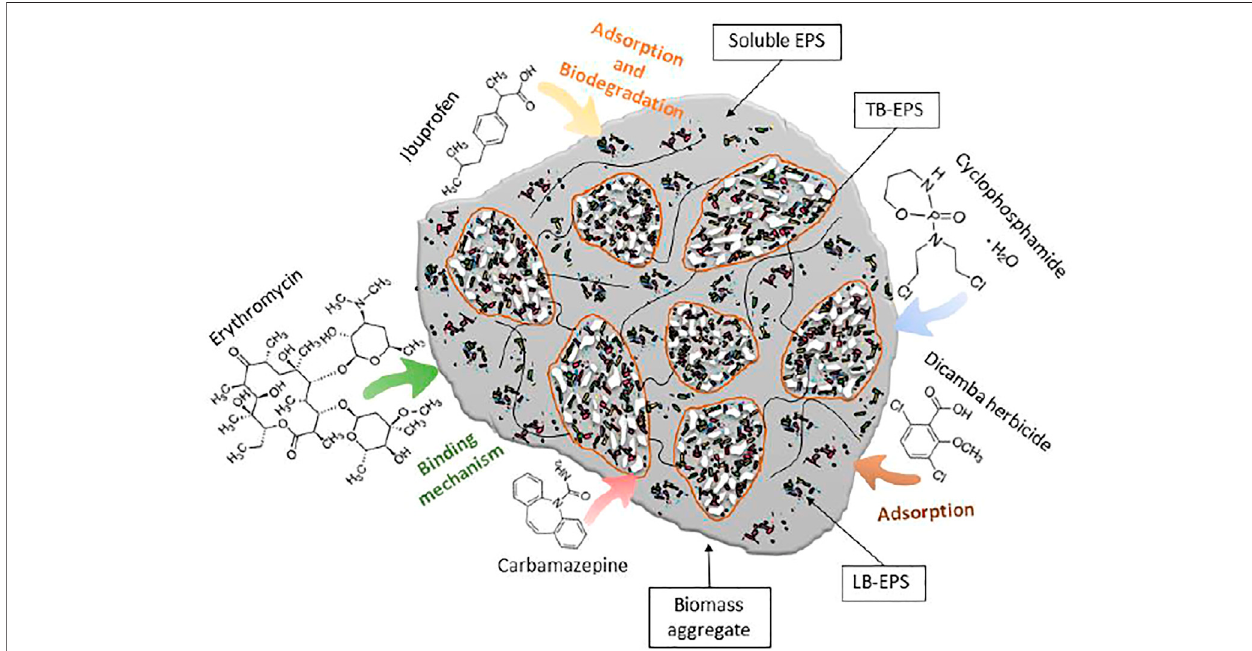
FIGURE 1 | Proposed interaction mechanisms of the microbial EPS in bioaggregates interacting with micropollutants. Complexes formed between EPS and pollutants through hydrophobic interaction, hydrogen bond, or electrostatic interaction.